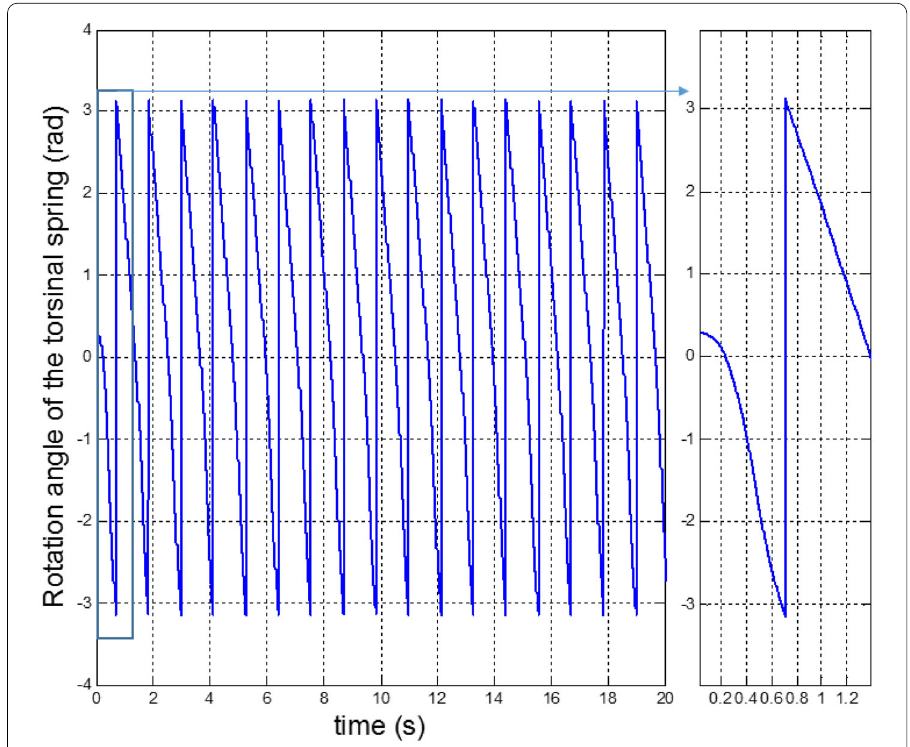
Fig. 19 Spring rotation angle time history—classical midpoint rule for (cid:15) t = 10 − 3